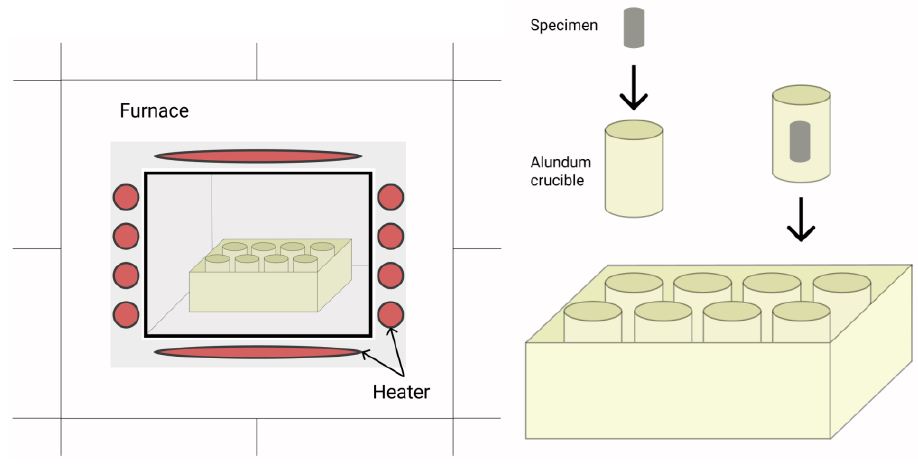
Figure 1. A schematic illustration of the equipment for the oxidation test.